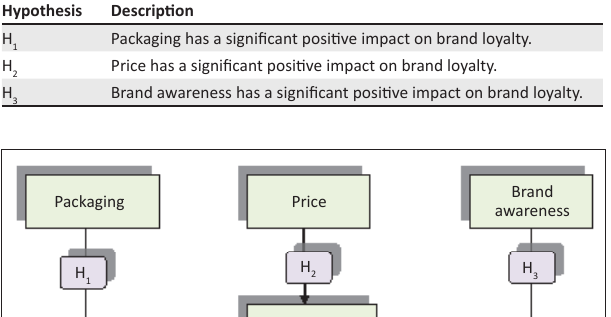
TABLE 1: Summary of hypotheses. Hypothesis Description